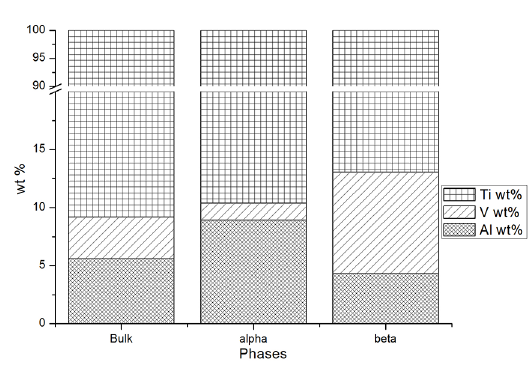
Figure 6 . Weight percentages (wt%) of Al, V, and Ti in bulk alloy, α phase, and β phase, as measured by energy-dispersive X-ray spectroscopy of untreated Ti6Al4V sample.